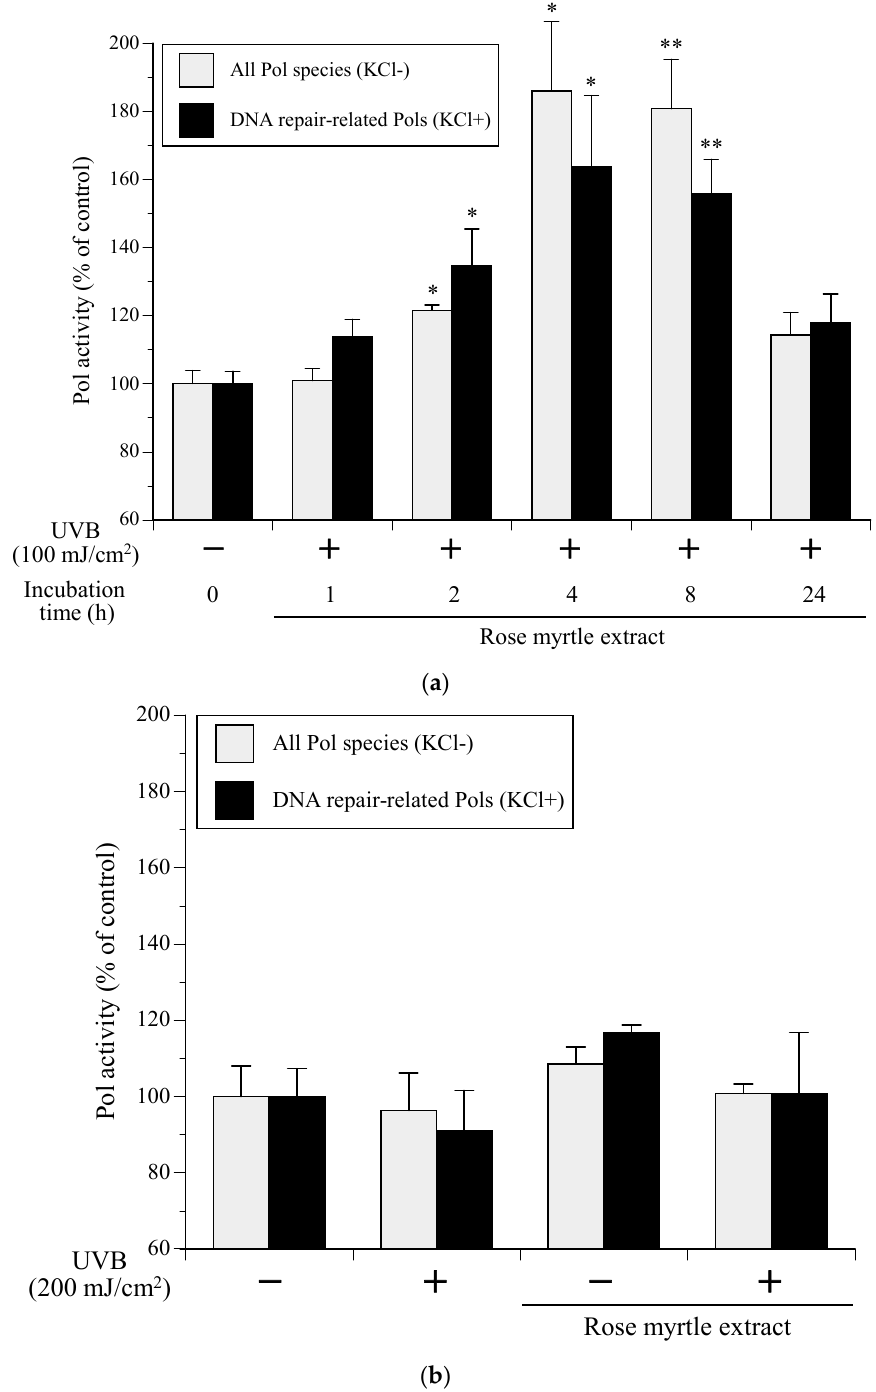
Figure 4. Effects of rose myrtle extract and UVB irradiation on the activity of cellular Pols in NHEKs. ( a ) NHEKs were cultured with rose myrtle extract (10 μ g/mL) for 24 h, and then Pol activity was dependent upon incubation time (1–24 h) irradiated with 100 mJ/cm 2 UVB; ( b ) NHEKs were cultured with or without rose myrtle extract (10 μ g/mL) for 24 h, irradiated with or without an excess amount of UVB (200 mJ/cm 2 ), and then incubated for 4 h. Cellular Pol activity in treated NHEKs was measured. Gray bars represent human whole Pol (standard reaction conditions without 120 mM KCl) and black bars represent DNA repair ‐ related Pol species (with 120 mM KCl), respectively. Vehicle control Pol activity without UVB irradiation was arbitrarily designated 100%. All data are the mean ± SEM ( n = 3). * p < 0.05 and ** p < 0.01 compared with UVB − vehicle control.